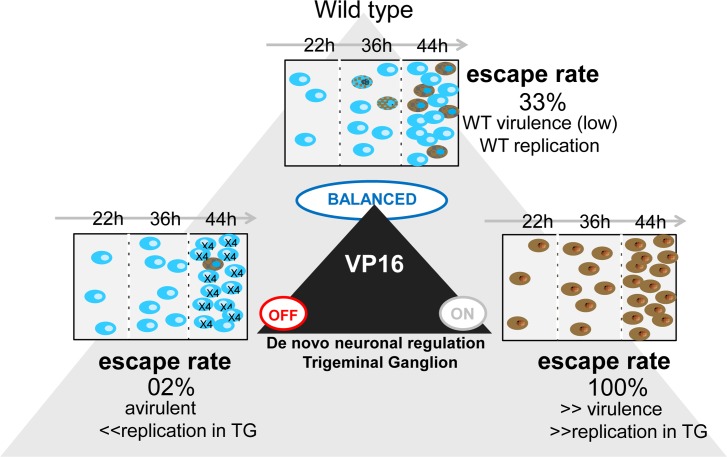
Regulation of de novo VP16 expression in neurons controls the exit from the default acute stage latent transcriptional program.Rectangular panels showing viral program usage in TG neurons at 22, 36, and 44 hours pi. Top panel: Wild type virus (17LATpLacZ). Progression from only latent transcriptional program usage at 22 hrs pi (blue neurons only) to ~33% of the accumulated blue neurons transitioning into the lytic program at 44 hrs pi is observed. These viruses display wild type replication and virulence properties. Left panel: Disruption of the pre-immediate early regulatory region of the VP16 promoter, mutant 17VP16pπRR+LATpLacZ. Similar to WT numbers of neurons positive for the latent transcription program are seen at 22 hrs pi but the number of neurons transitioning into the lytic viral transcription program is reduced to 2%. These mutants replicate normally on eyes, but as would be expected from the reduced transition into the lytic cycle, replicate poorly in the TG and virulence was not observed. Right panel: Expression of VP16 from the LAT promoter, mutant 17LATpVP16. Expression of VP16 directly upon engagement of the latent transcription program results in entry into the lytic cycle in neurons at 22 hrs pi. Neurons continue to enter the lytic transcription program and viral replication in the nervous system and virulence are increased.